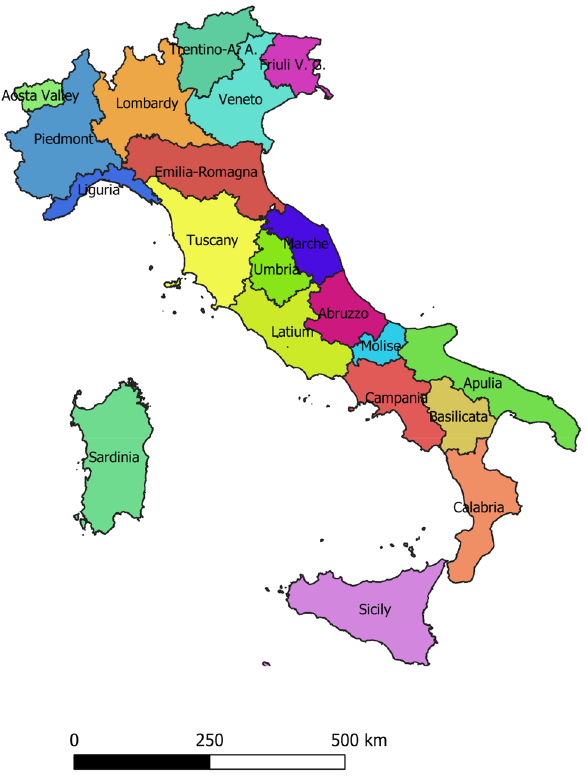
Figure 1. A stylized map of Italy with regional boundaries (this map was created using the Italian statistical atlas of municipalities, a free application downloaded from www. istat.